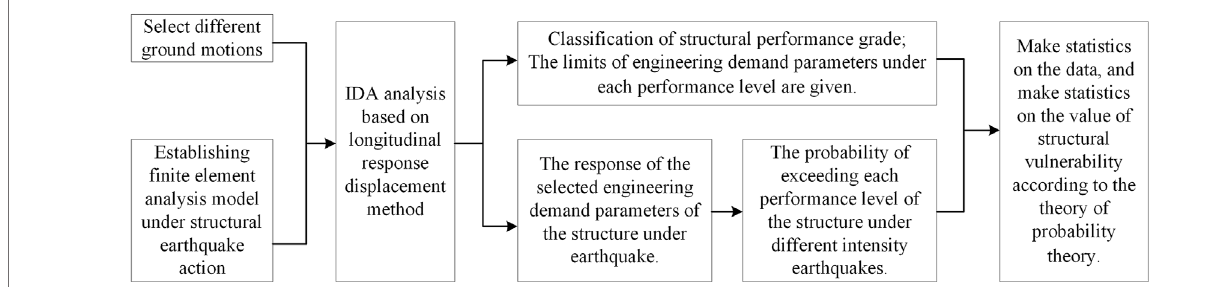
FIGURE 2 | The process of the structural seismic vulnerability analysis.